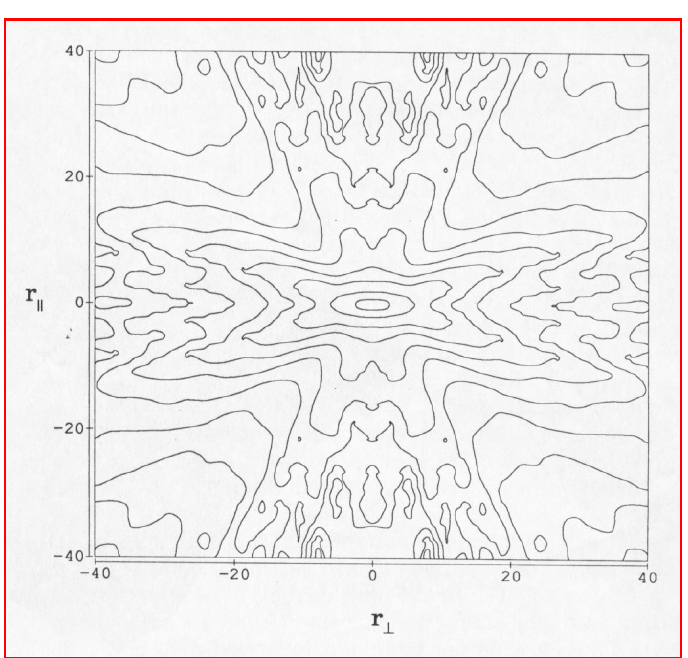
Figure 33: Contour plot of the 2D correlation function of interplanetary magnetic field fluctuations as a function of parallel and perpendicular distance with respect to the mean magnetic field. The separation in 𝑟 ‖ and 𝑟 ⊥ is in units of 10 10 cm. Image reproduced by permission from Matthaeus et al. (1990), copyright by